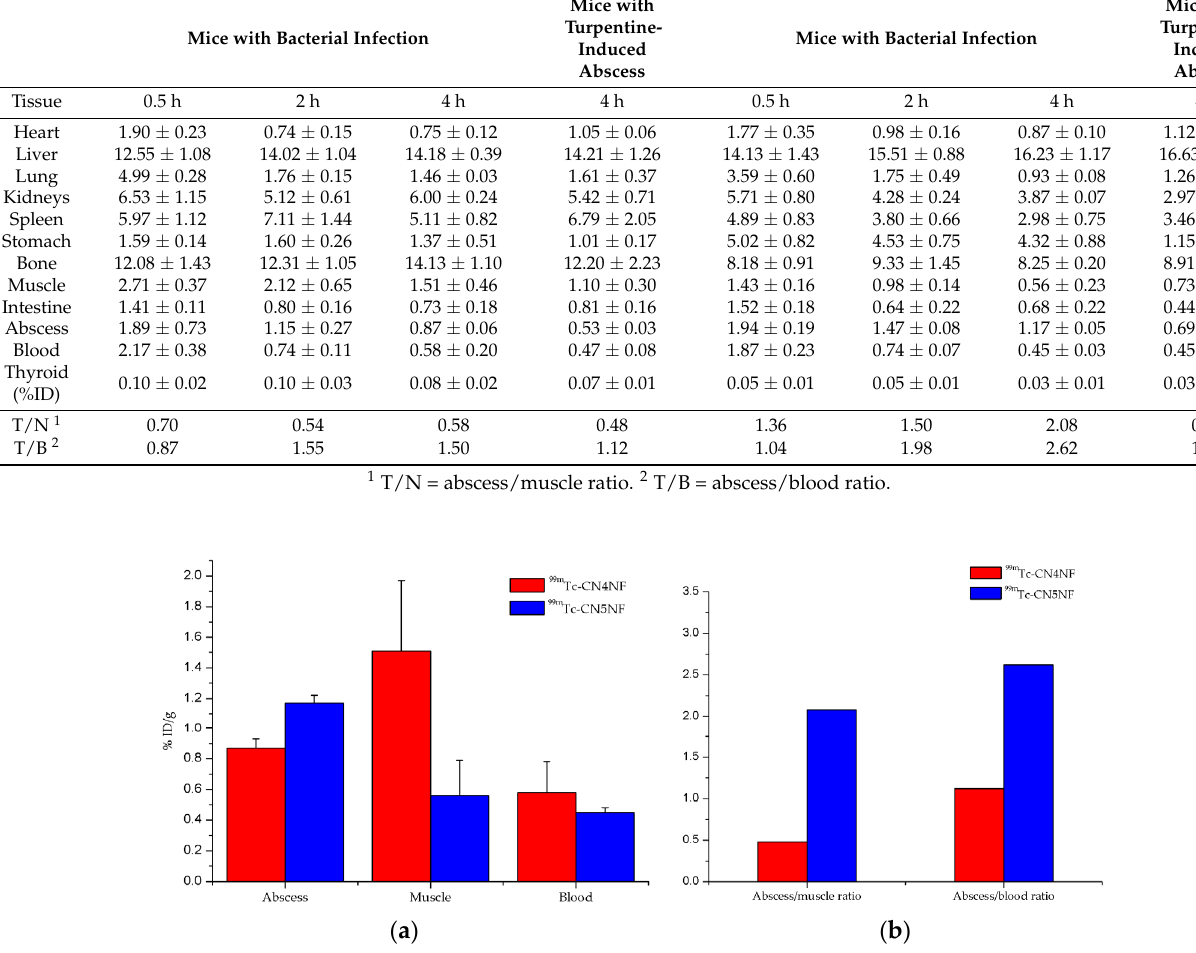
Table 1. Biodistribution of [ 99m Tc]Tc-CN4NF and [ 99m Tc]Tc-CN5NF in mice (% ID/g ± SD, n = 4).